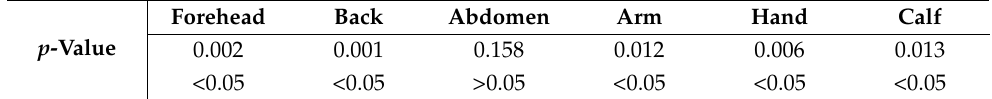
Table 6. Kruskal–Wallis H test of k independent samples of adult local thermal comfort vote.